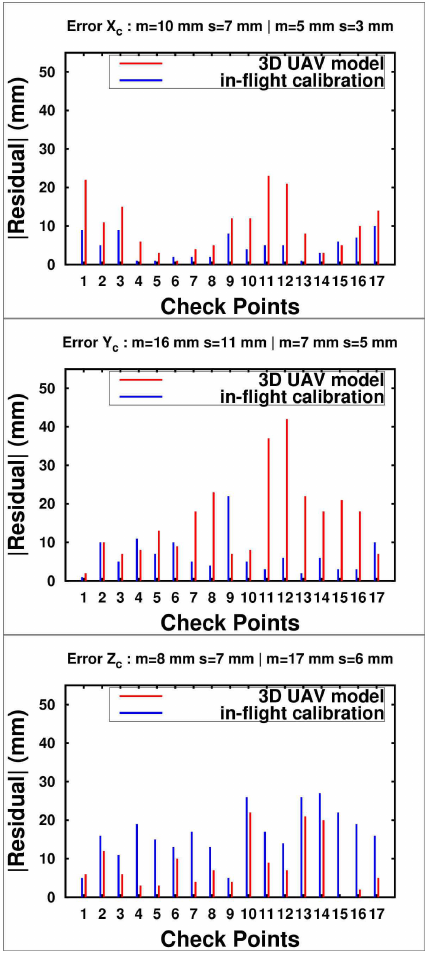
Figure 11: Comparison of absolute residuals using two different lever-arm calibration